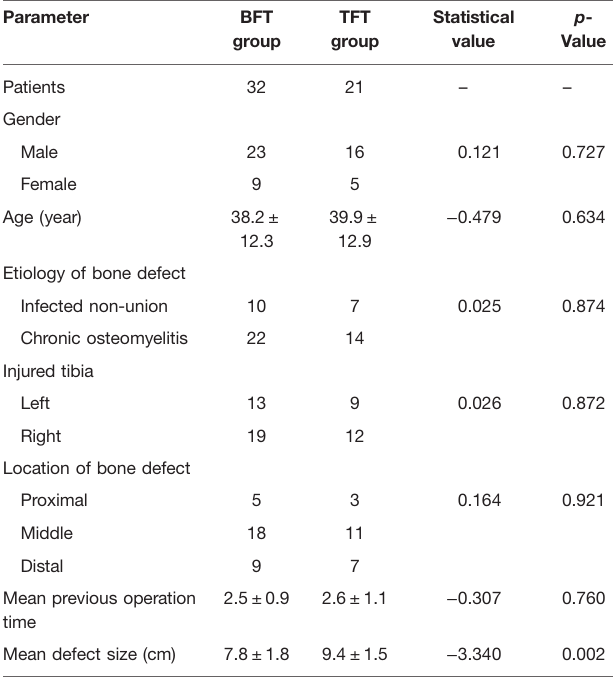
TABLE 1 | Demographics of the two groups. TABLE 2 | Comparison of the results of the two